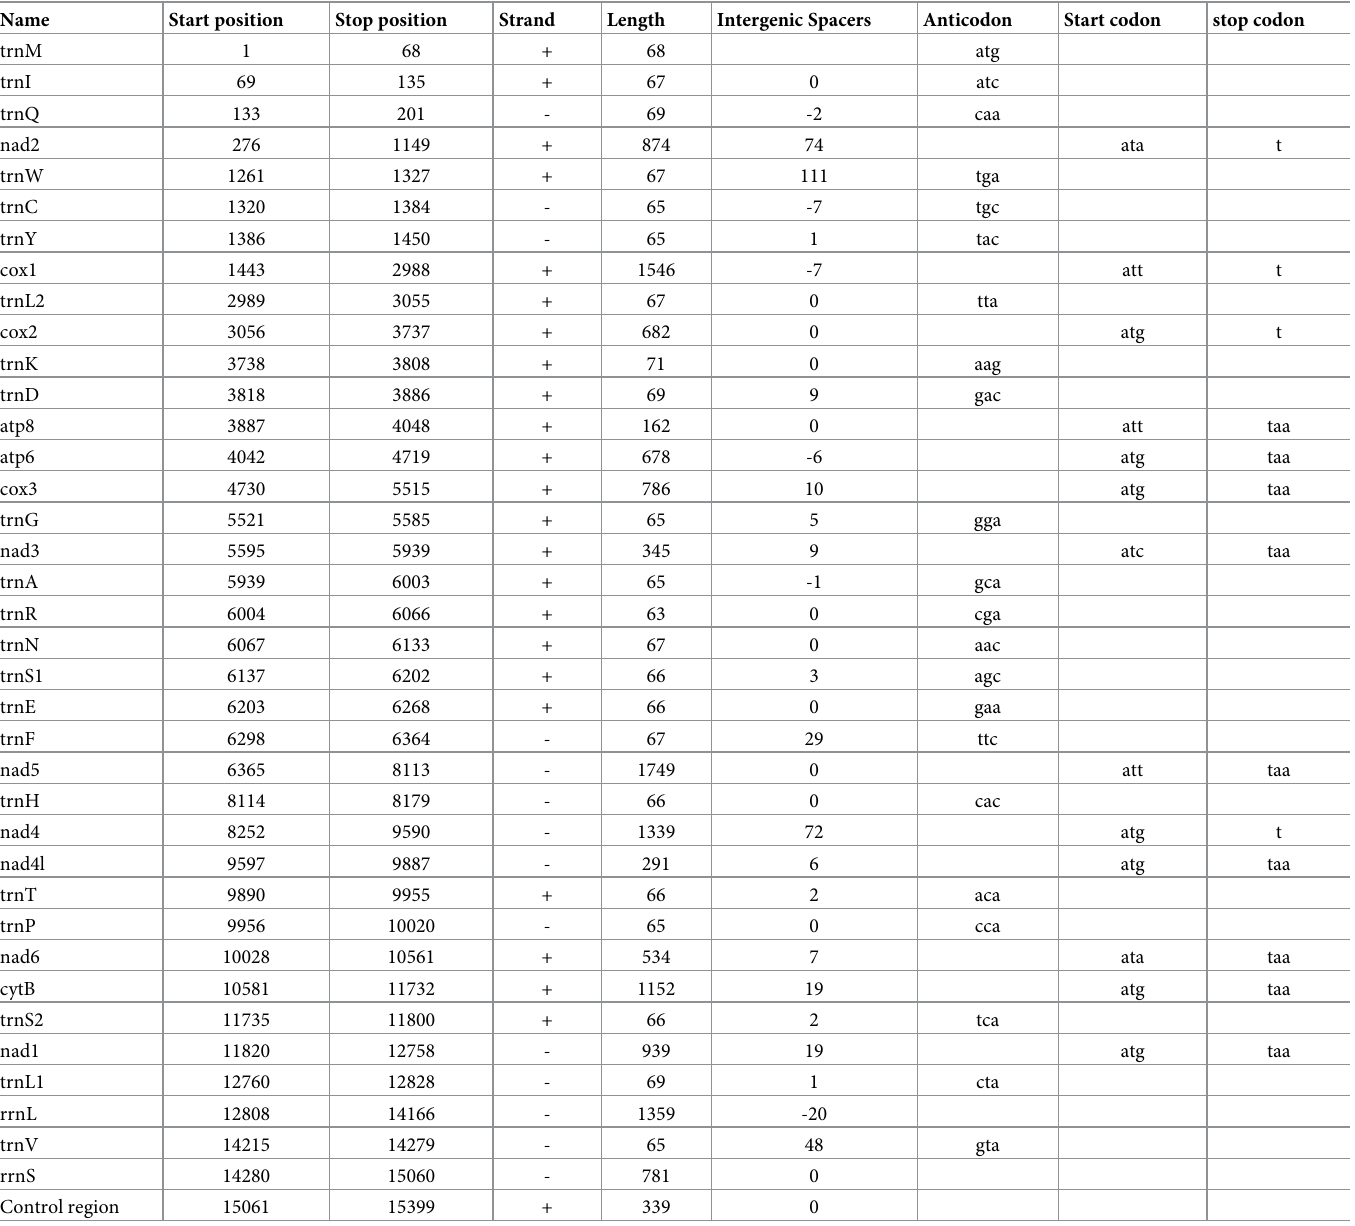
Table 1. Summary table for characteristics of the complete mitogenome of Chrysodeixis acuta